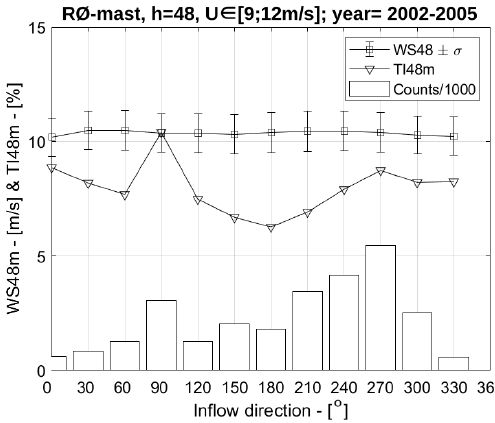
Figure 6. Streamwise TI and mean wind speed at 48m height for different wind directions from measurements filtered for a wind speed range of 9–12ms − 1